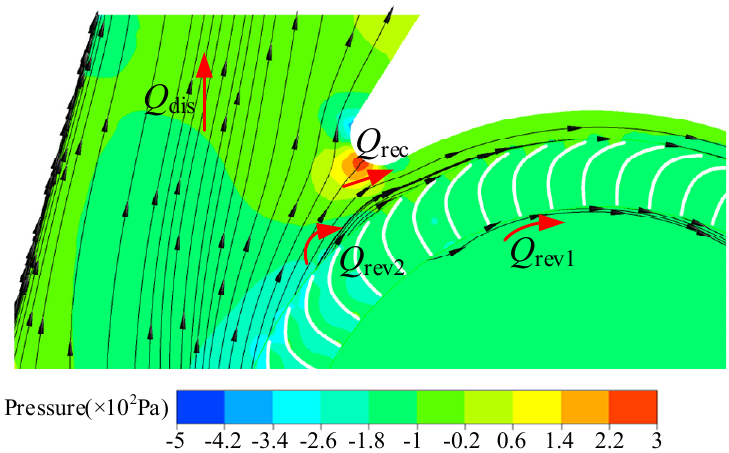
Figure 19. Airflow in the area near the volute tongue.